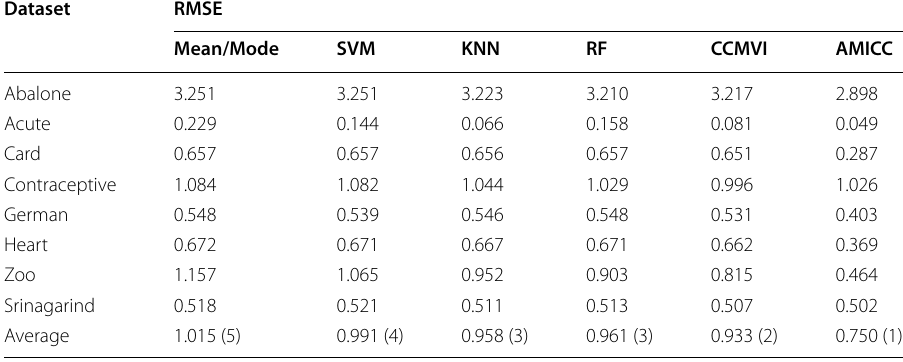
Table 11 Average RMSEs of the MVI methods for the mixed datasets Dataset